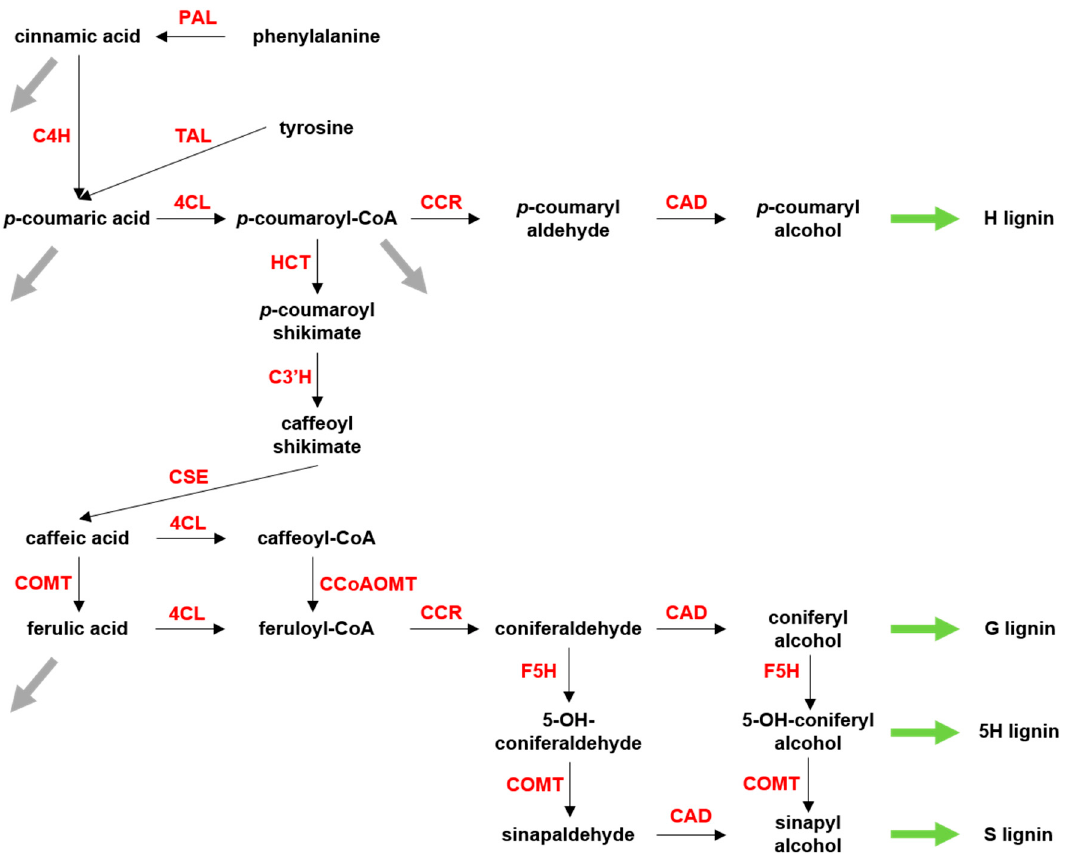
Figure 1. Lignin biosynthesis pathway in switchgrass ( Panicum virgatum ). The pathway mainly uses phenylalanine as starting compound. The reactions take place in the cytosol, and the monolignol end products are translocated to the plant cell wall, transformed into lignin monomers, and polymerized to form lignin. In switchgrass, the overall lignin composition is ~5% H, 45–50% S, and 45–50% G-lignin.